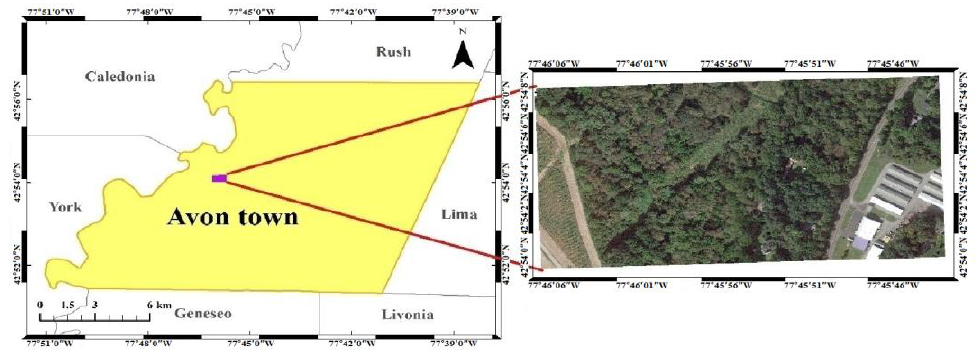
Figure 1. Map and image of the study